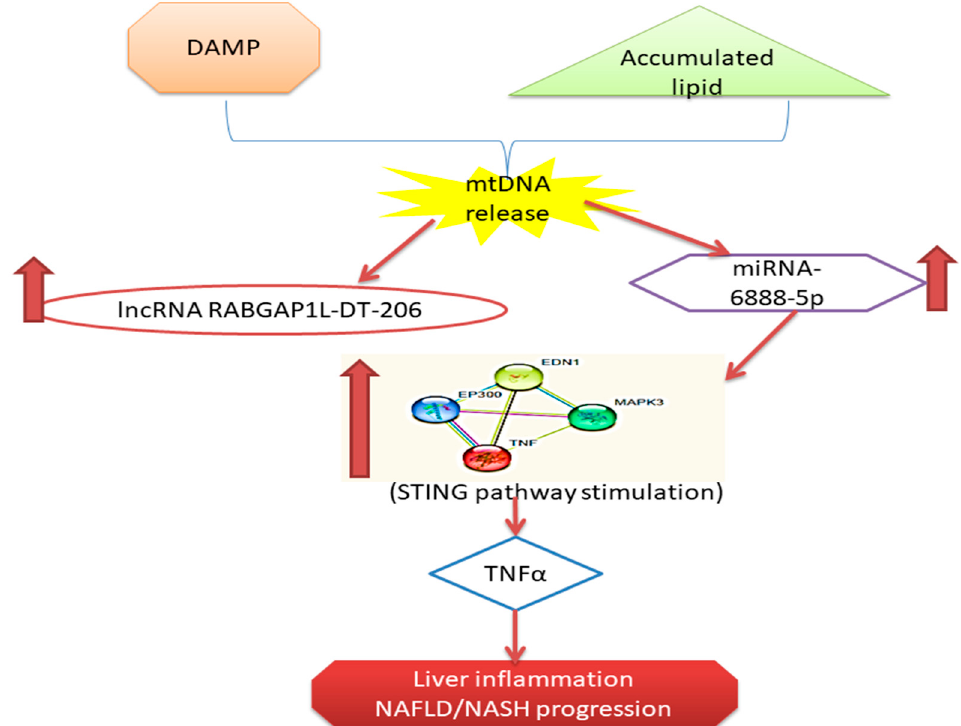
Figure 6. Summary and schematic presentation of the study